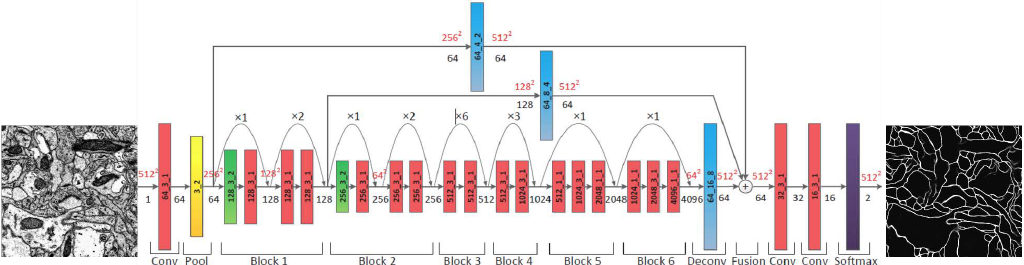
Figure 7. The network architecture for recognition of the neuronal membrane [29]. Red and green blocks annotated M , N , and S represent convolutional layers with channels M , kernel size N × N , and stride S ; yellow blocks denoted N and S imply max pooling over N × N patches with stride S ; blue blocks with M , N , and S denote deconvolution layers, and the parameters are similar to that of the convolutional layers; the purple box indicates the softmax layer; the red numbers above straight arrows imply the size of feature maps, while the numbers below straight arrows imply the channels of feature maps, and the numbers above curved arrows represent the repetitions of residual units.